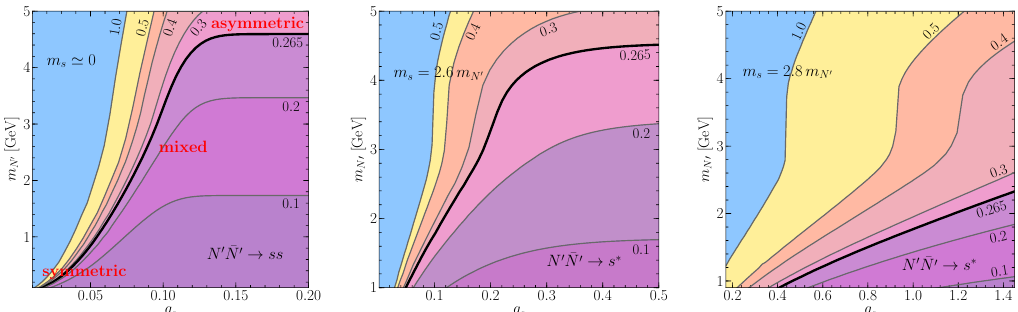
Figure 1 . Contours of DM relic density (cid:10) in the plane of DM mass versus coupling N 0 (cid:17) (cid:26) N 0 =(cid:26) crit to singlet, for three relations of singlet mass m to the DM mass m . Left: m , with s N 0 s (cid:28) m N 0 N 0 (cid:22) N 0 ss annihilation. Center: m s = 2 : 6 m N 0 with N 0 (cid:22) N 0 s (cid:3) (virtual s ) annihilation. Right: ! ! like center, but with m = 2 : 8 m The heavy contour labeled 0 : 265 corresponds to the observed s N 0 relic